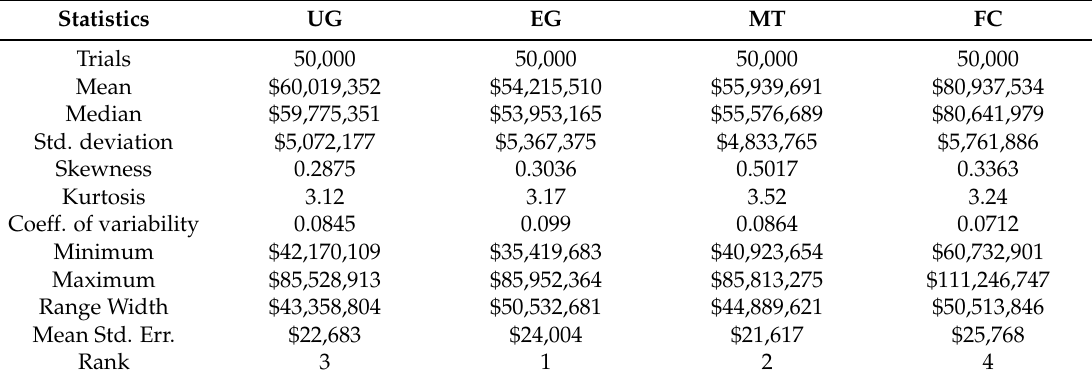
Table 5. Monte Carlo simulation results for Town